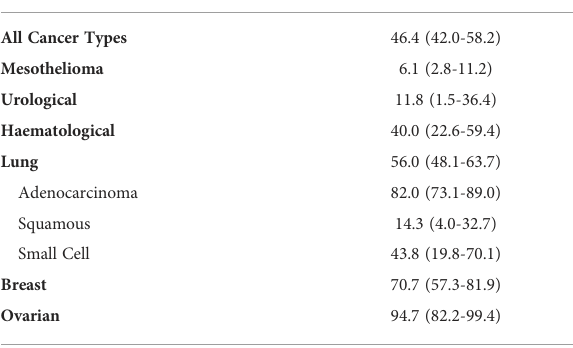
TABLE 1 Pleural Fluid cytological sensitivity by cancer type, adapted from Arnold et al.